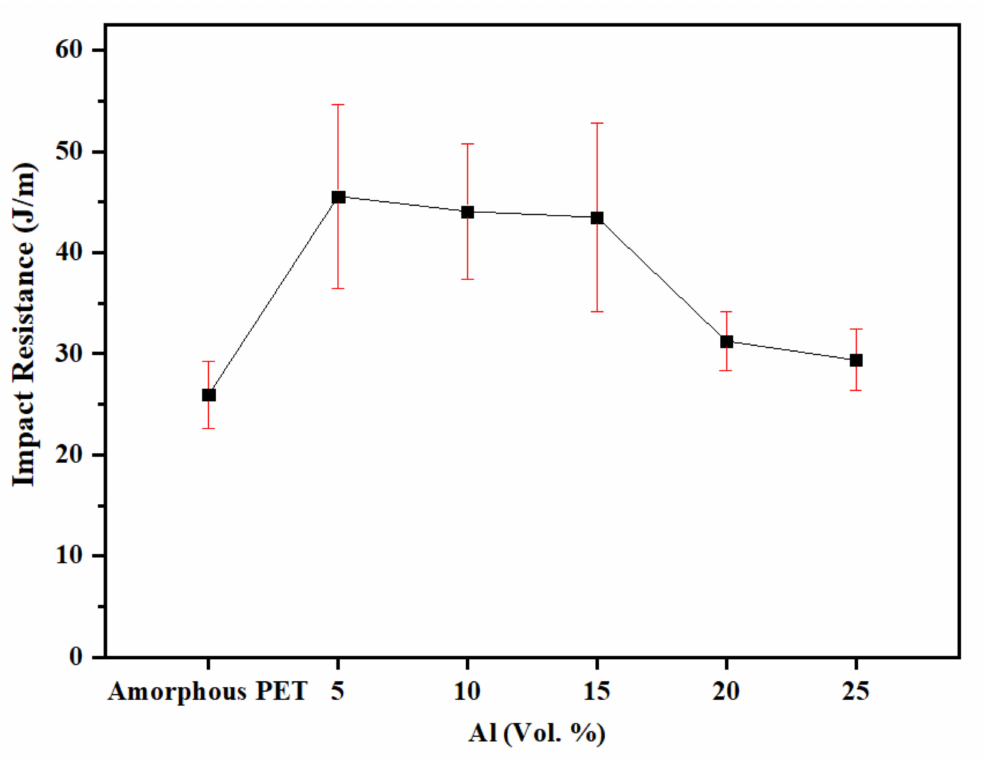
Figure 12. Notched Izod impact resistance of amorphous PET filled with Al nano platelets. Table 5. For the unpaired t-test, the null hypothesis was that there is no difference between the means of the two compositions that are compared, and the alternative hypothesis applied was that the two means are different at the 5% significance level. ‘Significant’ means the alternative hypothesis is accepted and that there is a difference between the means, and ‘non-significant’ means we accept the null hypothesis that there is no difference in the means; ‘vs.’ stands for